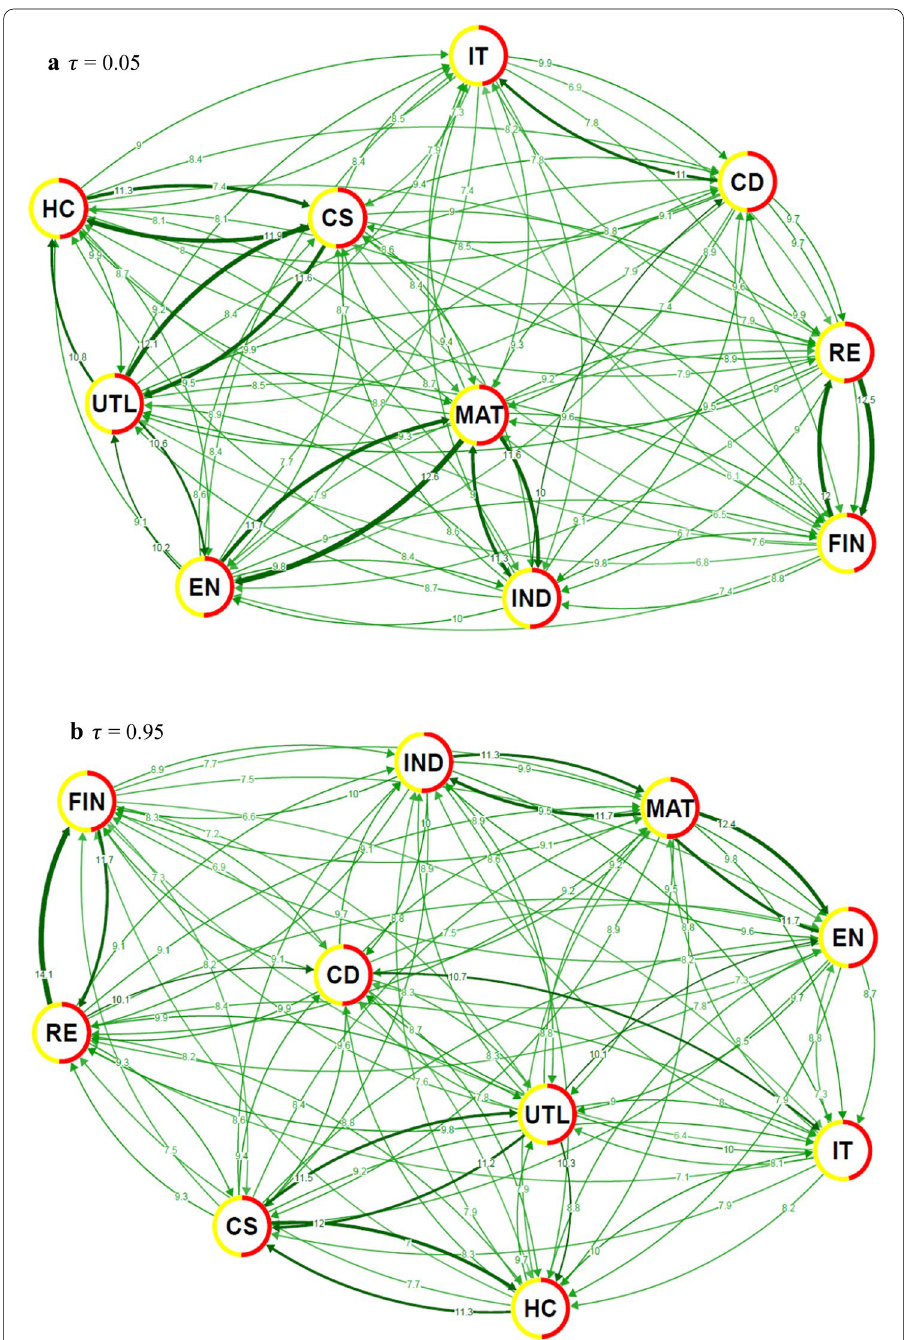
Fig. 6 Network visualizations for quantile level spillovers at lower ( τ return distributions. a τ